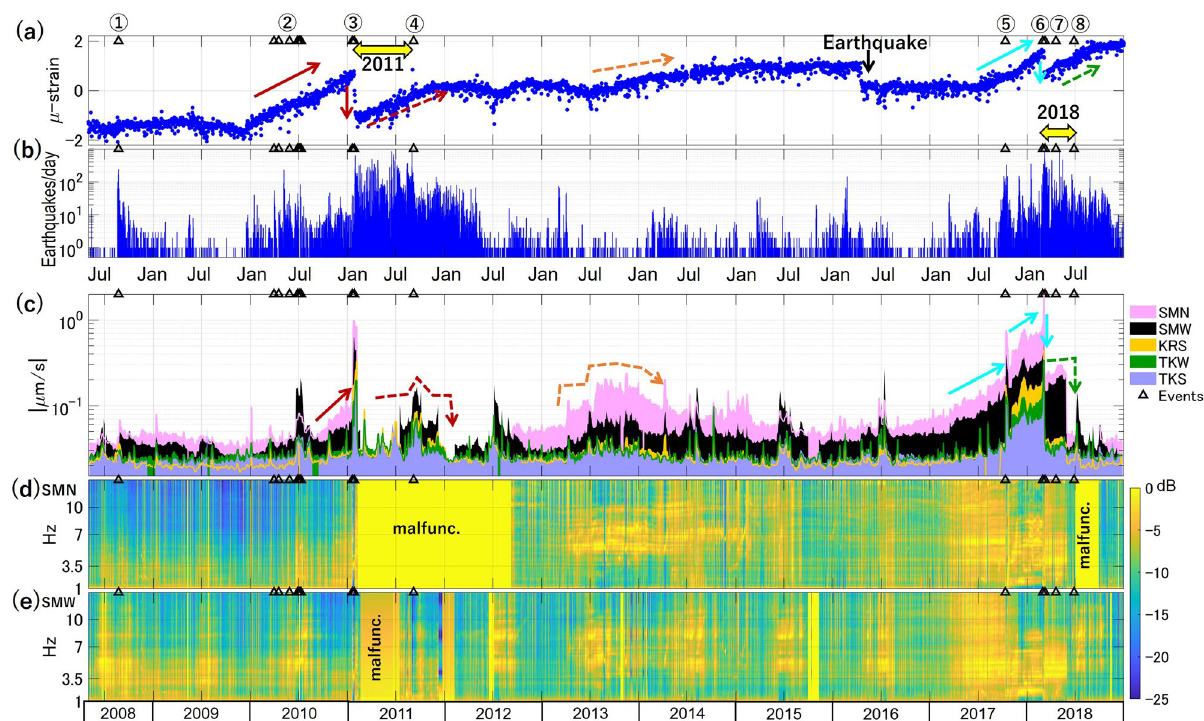
Figure 2. The variations of SBL compared to other monitoring data. ( a ) The areal strain (in micro-strain) indicating the deep inflation 43 . ( b ) Daily counts of shallow earthquakes determined by JMA beneath Shinmoe- dake. The count does not include tremor or very-long-period events. ( c ) Logarithmic plots of weekly smoothed SBLs at the five stations indicated by the corresponding colors in Fig. 1a. The area below each SBL value is color- filled for better visibility of the SBL ratio to the next stations. ( d ) and ( e ) The daily SBL spectra, P SBL , at SMN and SMW, respectively. The black triangles and circled numbers mark the events represented in Fig.